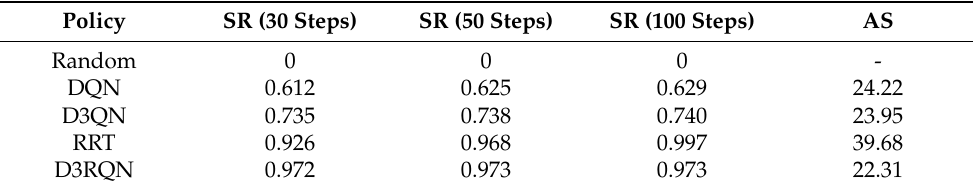
Table 6. The global path planning performance of different planners.